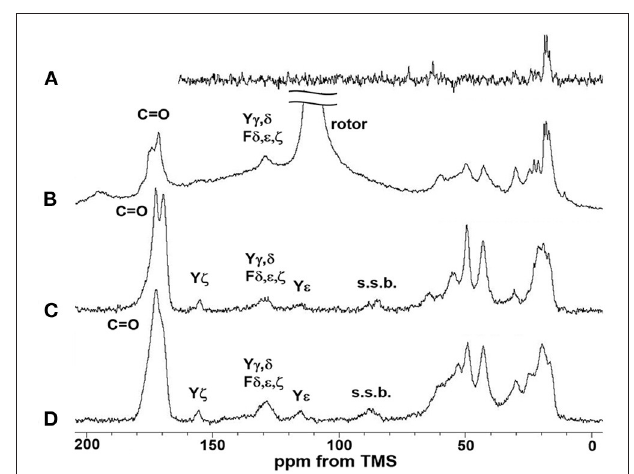
FIGURE 5 | (A) 13 C INEPT, (B) 13 C DD/MAS and (C) 13 C CP/MAS NMR spectra of EL–SF grafts in the hydrated state together with (D) 13 C CP/MAS NMR spectrum of elastin–silk fibroin graft in the dry state. Only the field lower than 80 ppm was assigned in this figure and the field higher than 80 ppm was assigned in Figure 6 . The largest peak in (B) is due to rotor and the peaks s.s.b.in (C) and (D) are due to spinning side band.